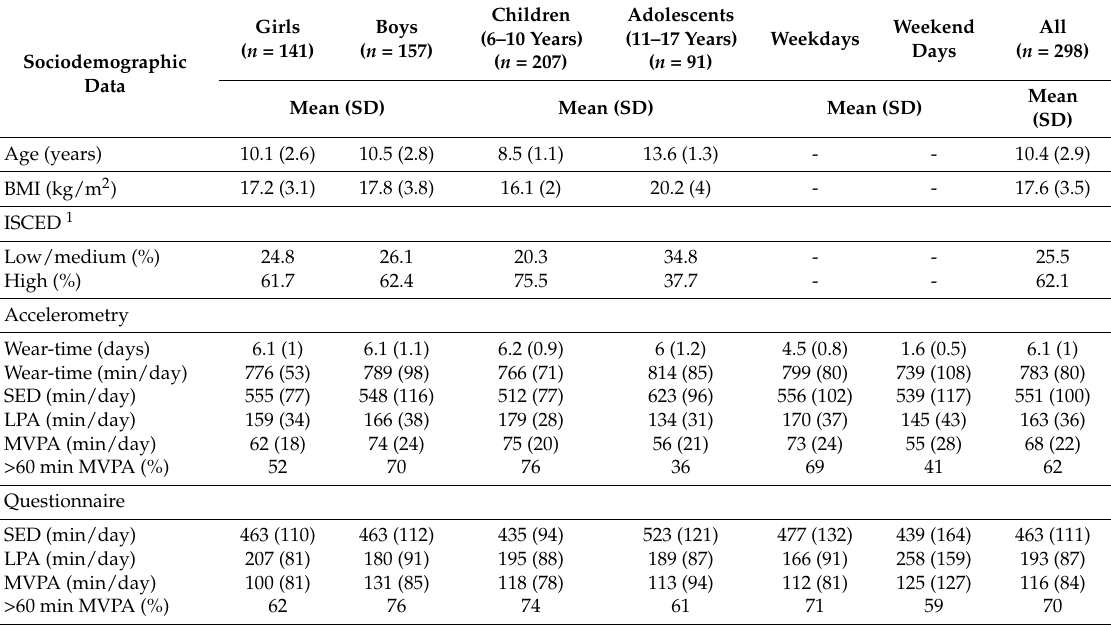
Table 1. Description of the study